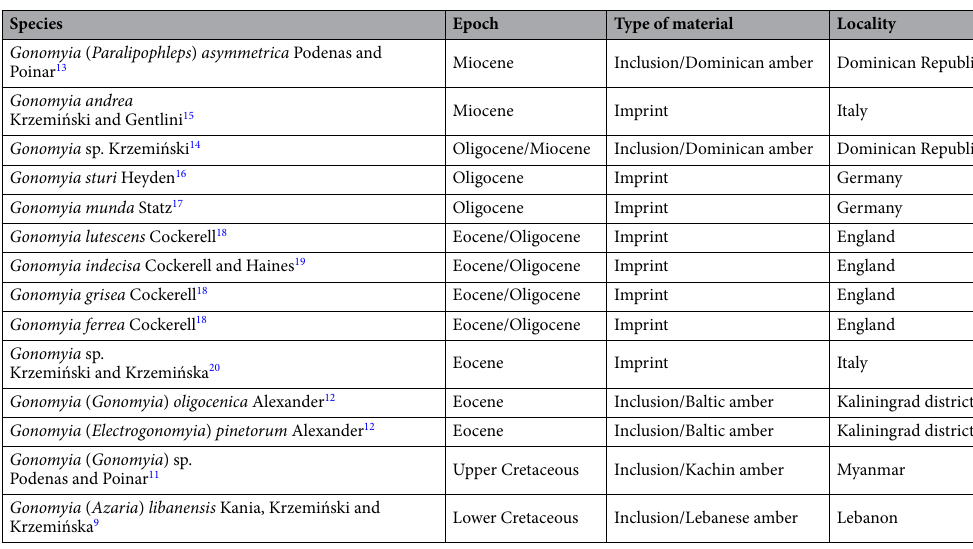
Table 1. List of fossils belonging to genus Gonomyia , age and